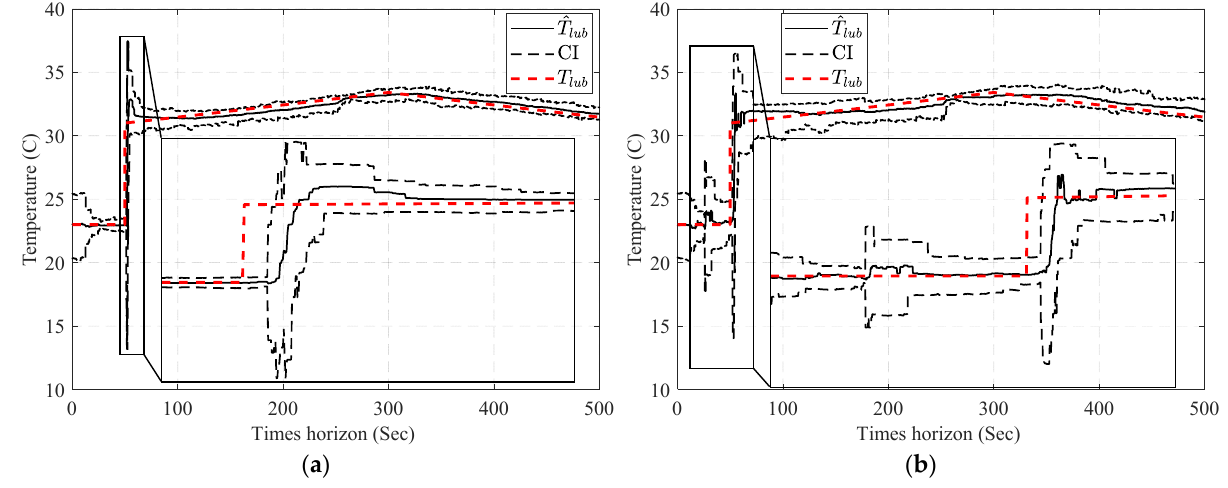
Figure 9. Result of the estimated 𝑇 (cid:3039)(cid:3048)(cid:3029) , using PF: ( a ) low noise scenario and ( b ) high noise scenario.